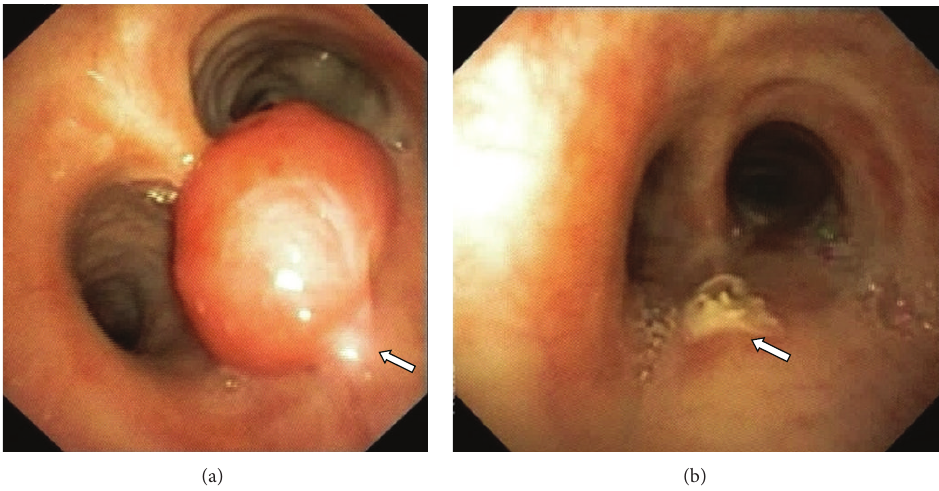
Figure 2: (a) Flexible bronchoscopic image showing a large fleshy polypoidal growth with well-defined narrow stalk (arrow) arising from the posterior wall of the lower trachea. (b) The electrosurgical excision successfully removed the tumor in toto (b). There was no bleed or gross evidence of residual tumor at the intervention site (arrow).